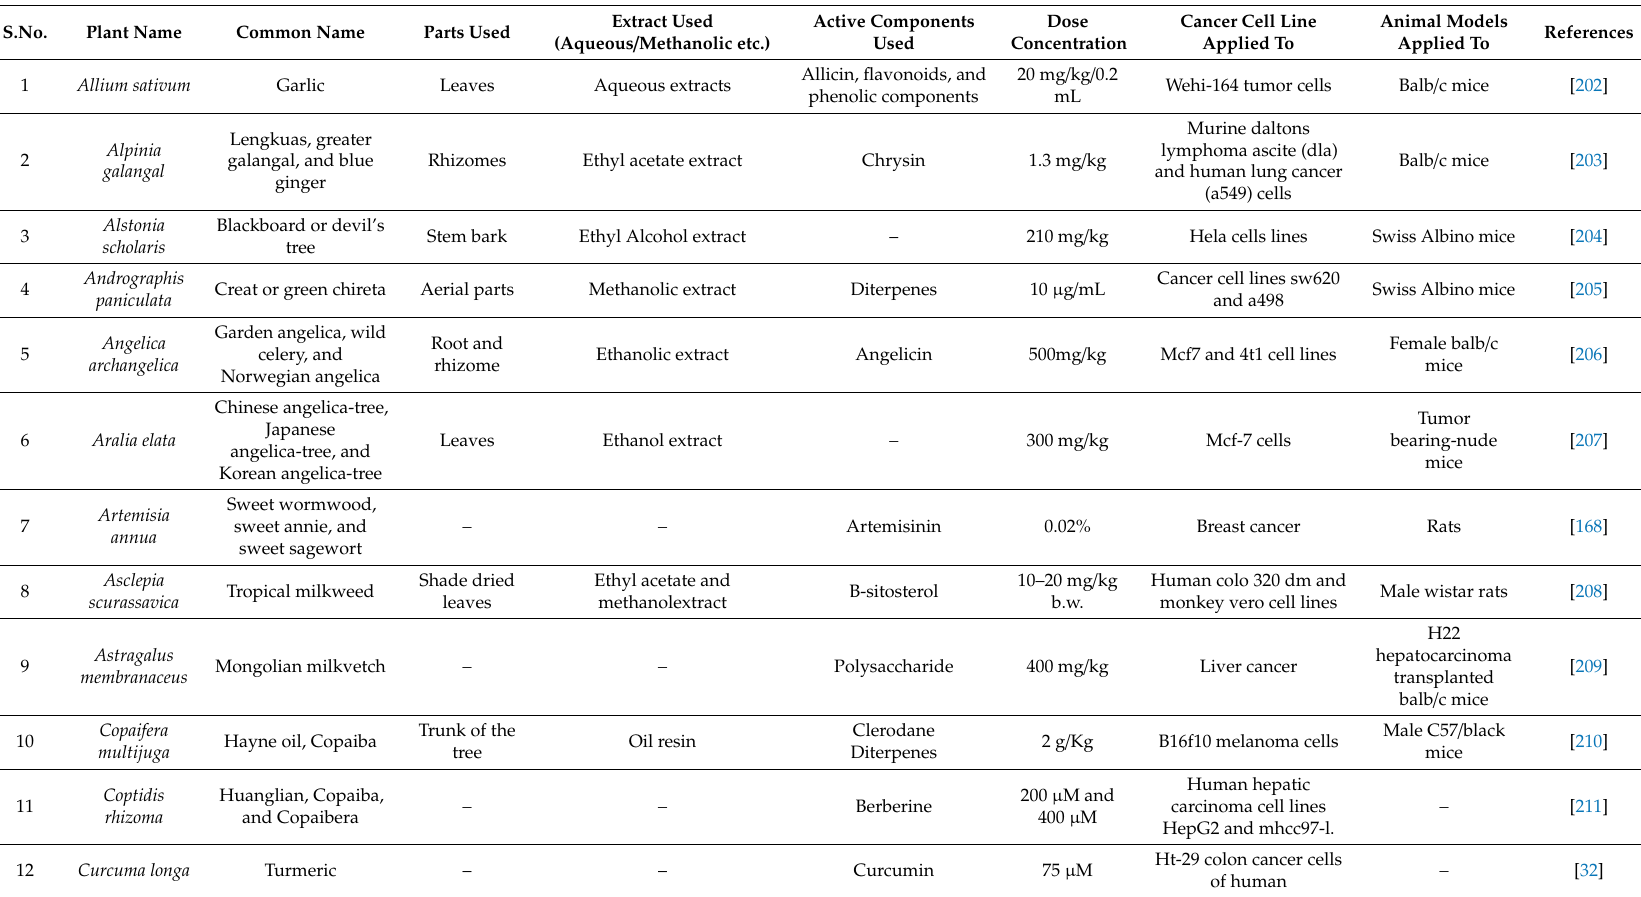
Table 1. Some of the important anticancer medicinal plants, their active components, and in vitro and in vivo activity.